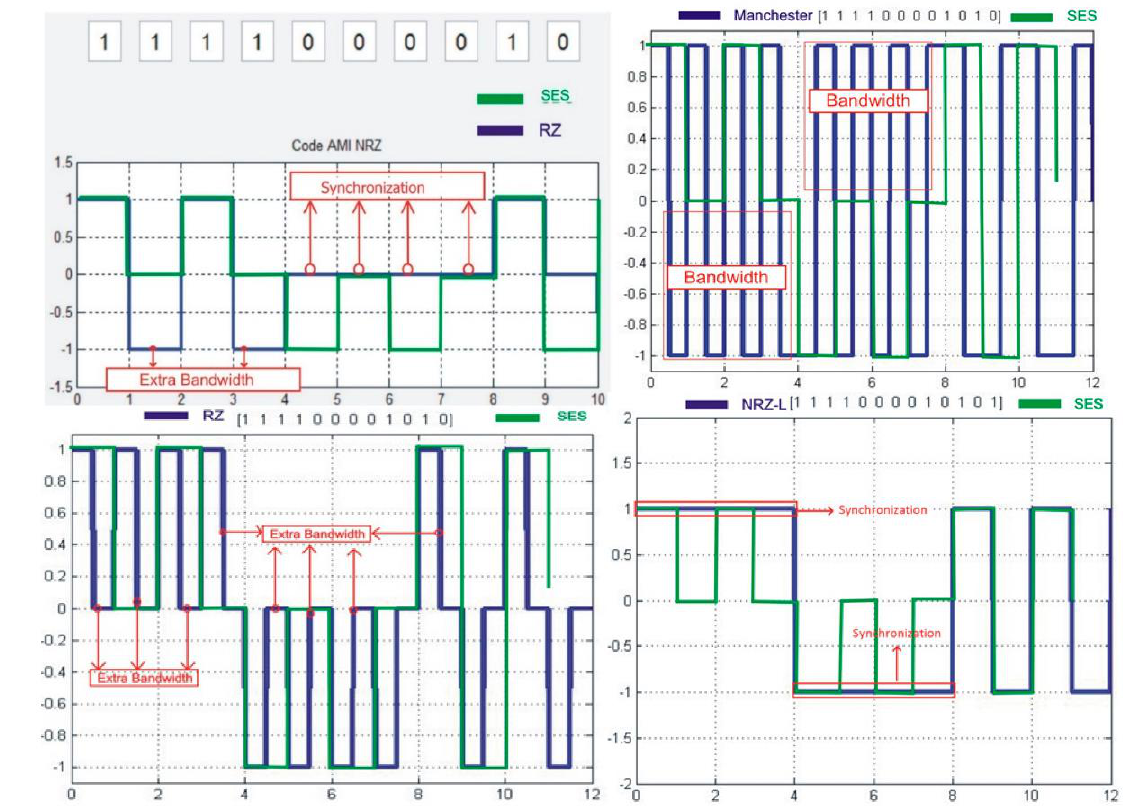
Figure 11. PSD and bandwidth utilization between SES and other digital encoding schemes.